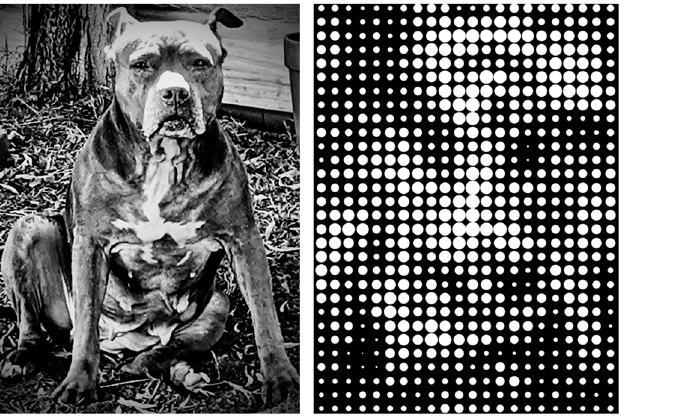
Fig 1. Scoreboard model of pixel doctrine.